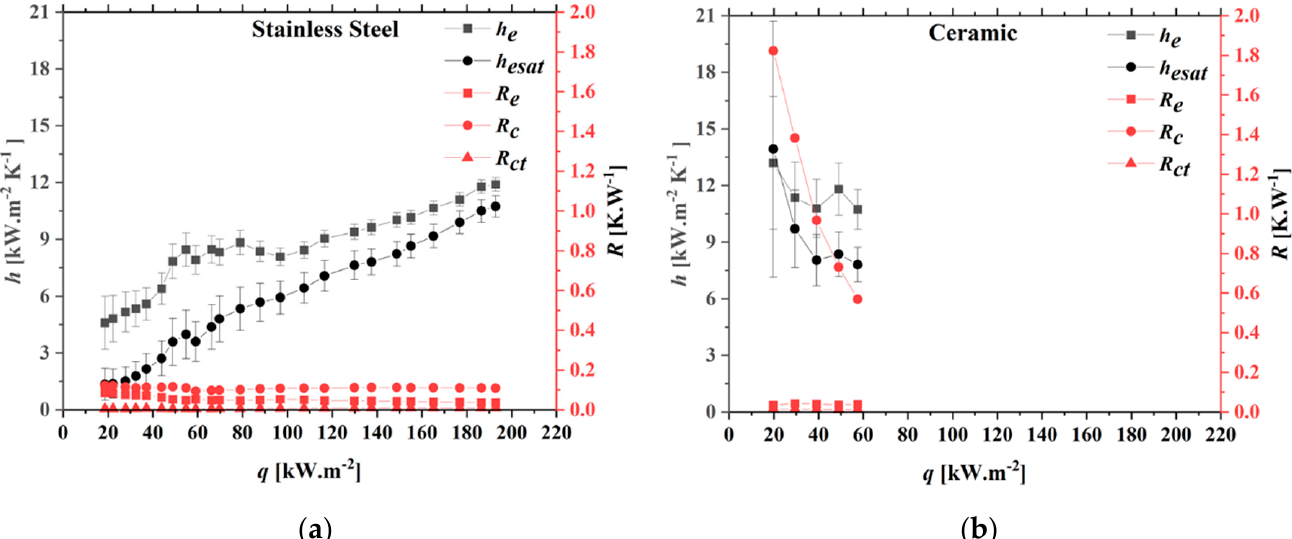
Figure 12. h e , R, vs. q of ( a ) a stainless steel wick and ( b ) a ceramic wick. In both experiments of stainless steel and ceramic LHPs, the evaporator heat transfer coefficient obtained from T eo was higher than the values calculated from saturation temper- ature T esat . Observing the difference in the results, the vapor might be superheated before leaving the evaporator. This superheating process could happen when vapor flows in the crossing grooves, and the heat of this process comes from the surrounding area of the fins and the grooves’ surface. The possible operating heat flux for the stainless-steel wick was higher than the ceramic wick. Comparing the evaporator heat transfer coefficient of the LHPs, the evaporator operating with the ceramic wick had the higher evaporator heat transfer coefficient when the heat transfer coefficient, h e, linearly increased with the heat flux in the LHP with the stainless steel wick. However, the ceramic LHP did not operate better than the stainless steel one. The significant mass flow rate of vapor requires large pore sizes in the ceramic wick to reduce resistance. Otherwise, the performance of